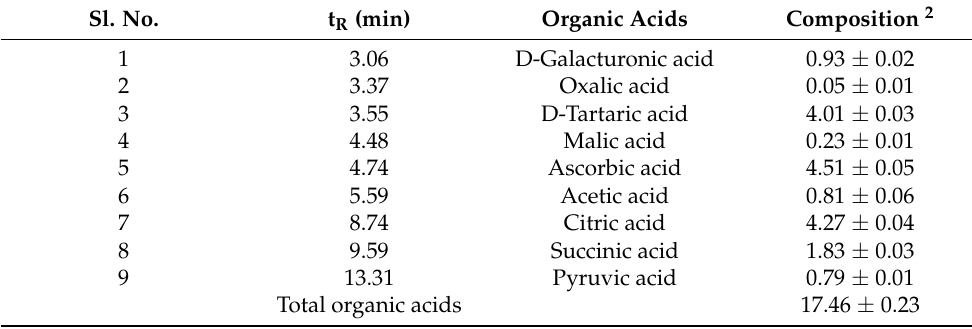
Table 4. Organic acid compositions of wood apple defatted fruit pulp (% DW) 1 . Sl. No. t R